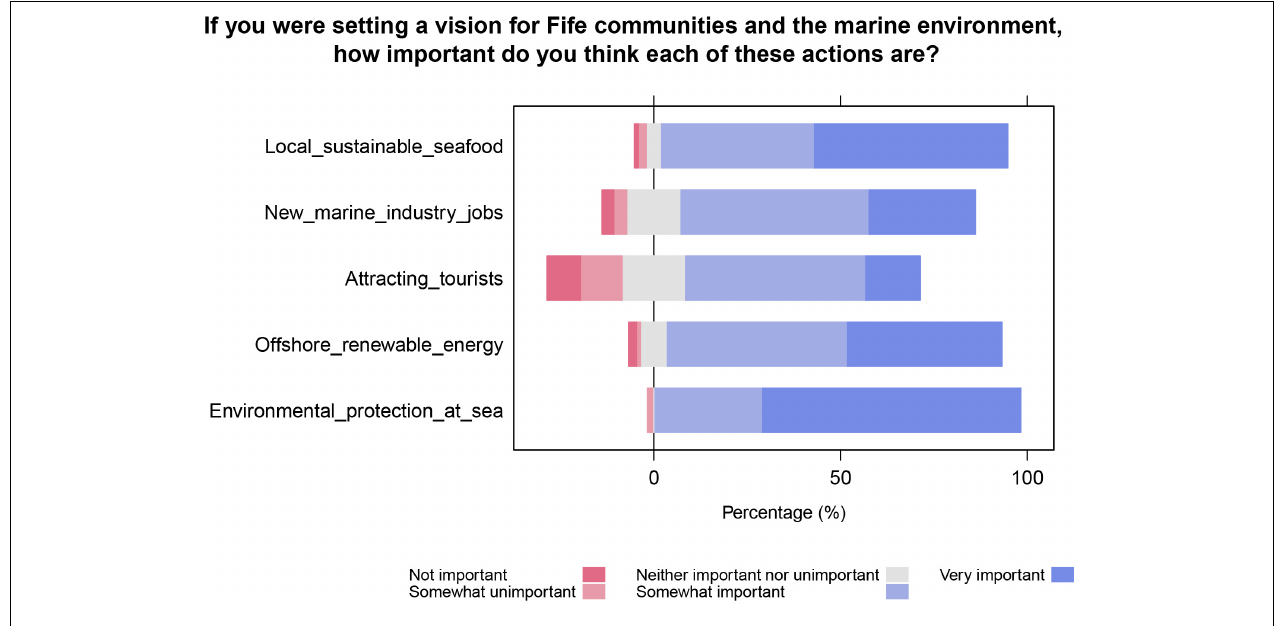
FIGURE 7 | Importance of selected outcomes for the future of Fife communities and marine environment ( n =